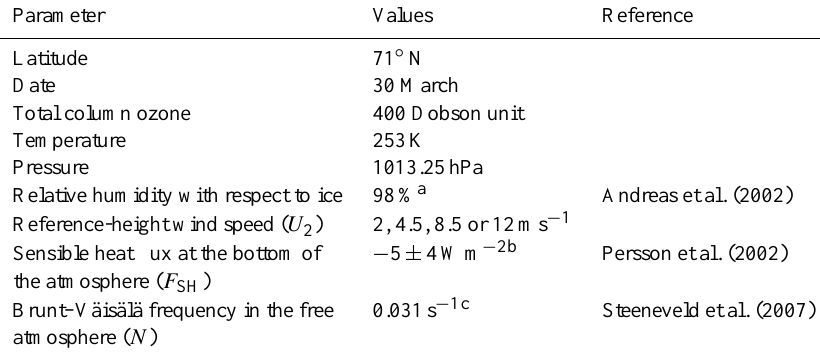
Table 2. Summary of meteorological and geographic conditions used in the model